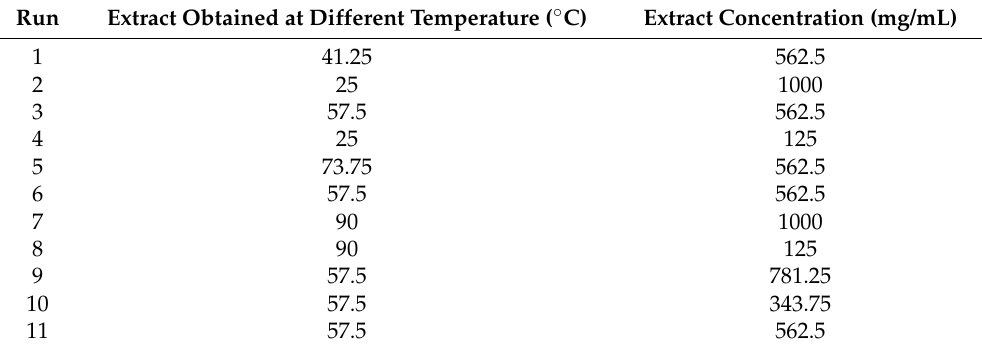
Table 3. Central composite rotatable design with two factors: temperature ( ◦ C) and aqueous extract concentration (mg/mL) for both hop samples on in vitro antifungal activity against F. oxysporum and A. solani